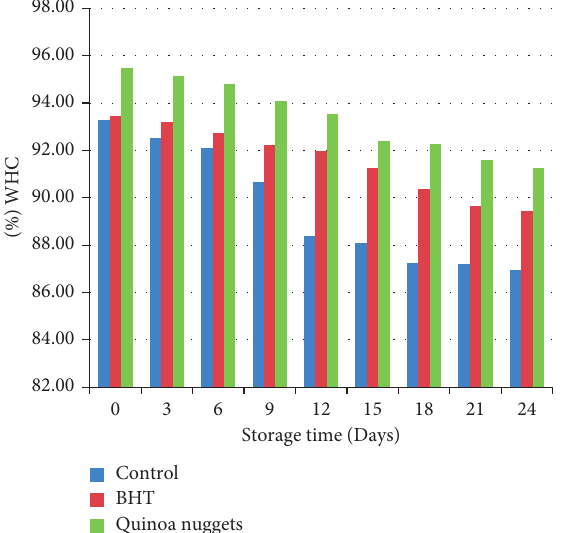
Figure 4: Water holding capacity (WHC) of chicken nugget samples during storage at 4 ° C for 24